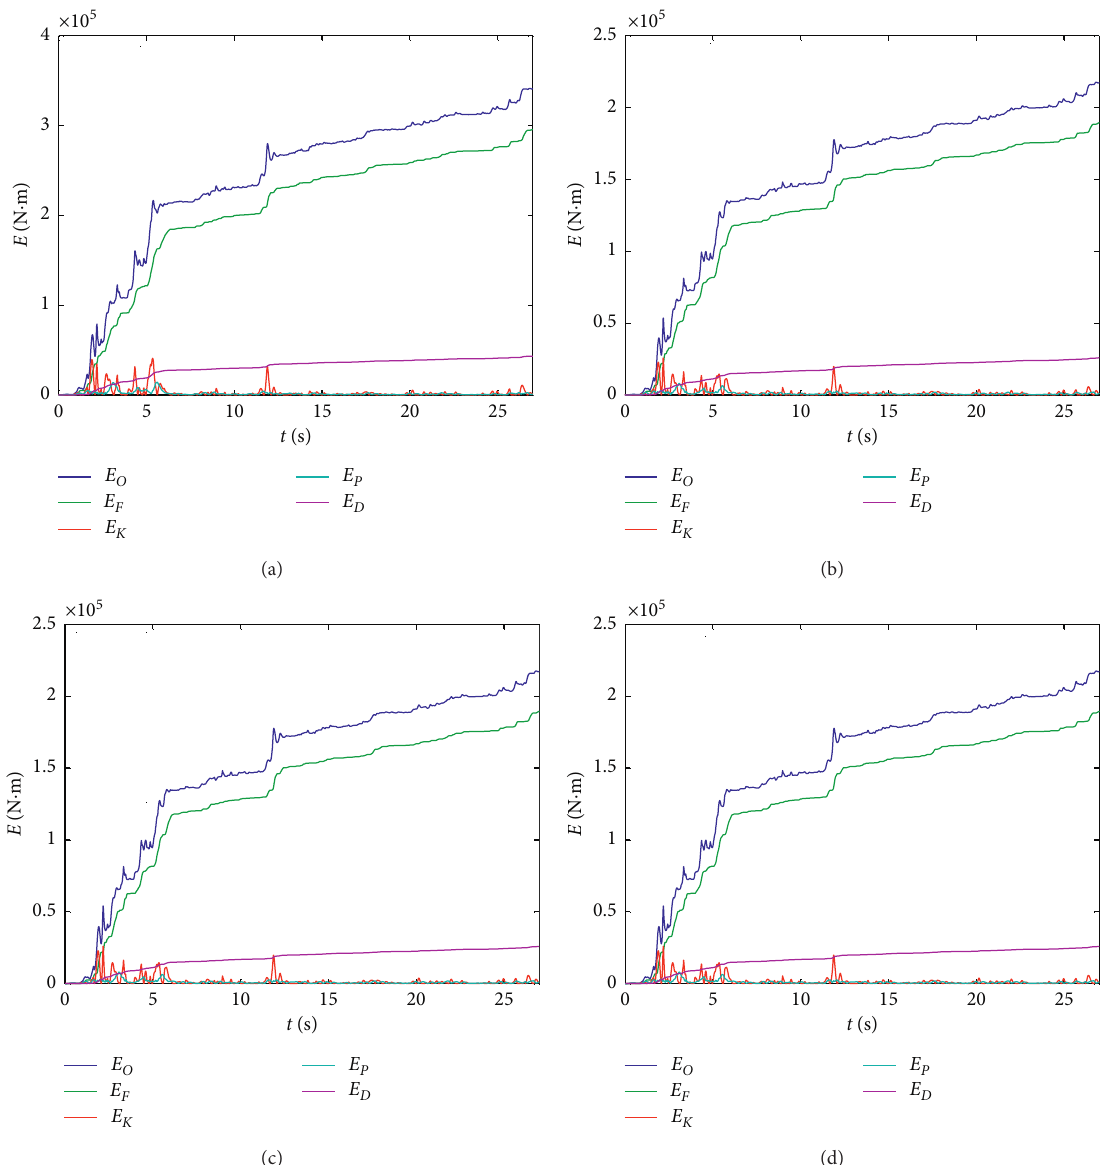
� 2.84s, μ � 0.05; El Centro seismic wave; peak g